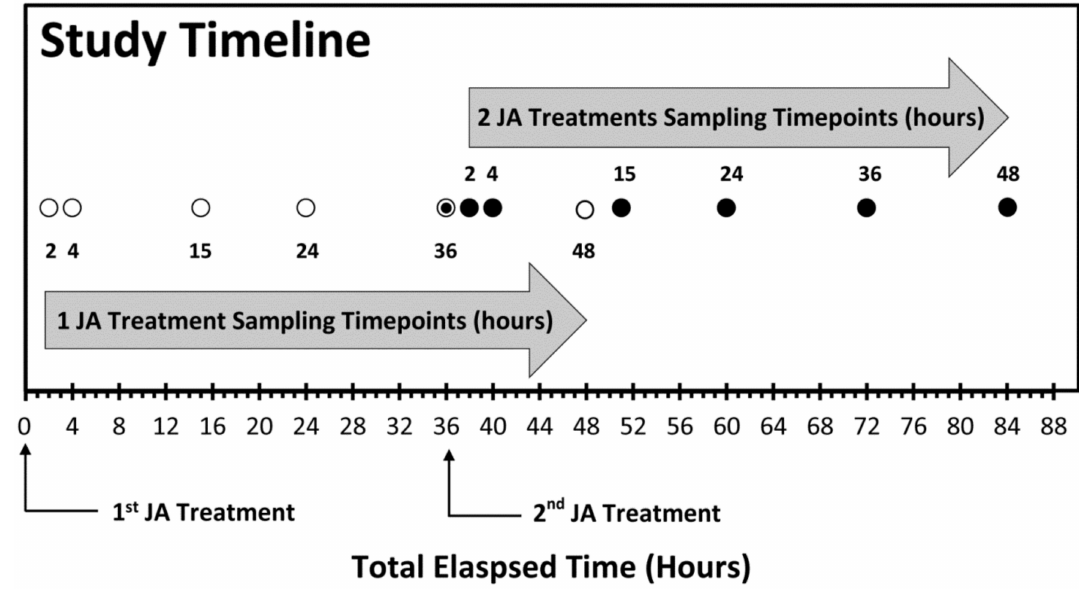
Figure 2. Study timeline showing sampling timepoints after one jasmonic acid (JA) treatment and two JA